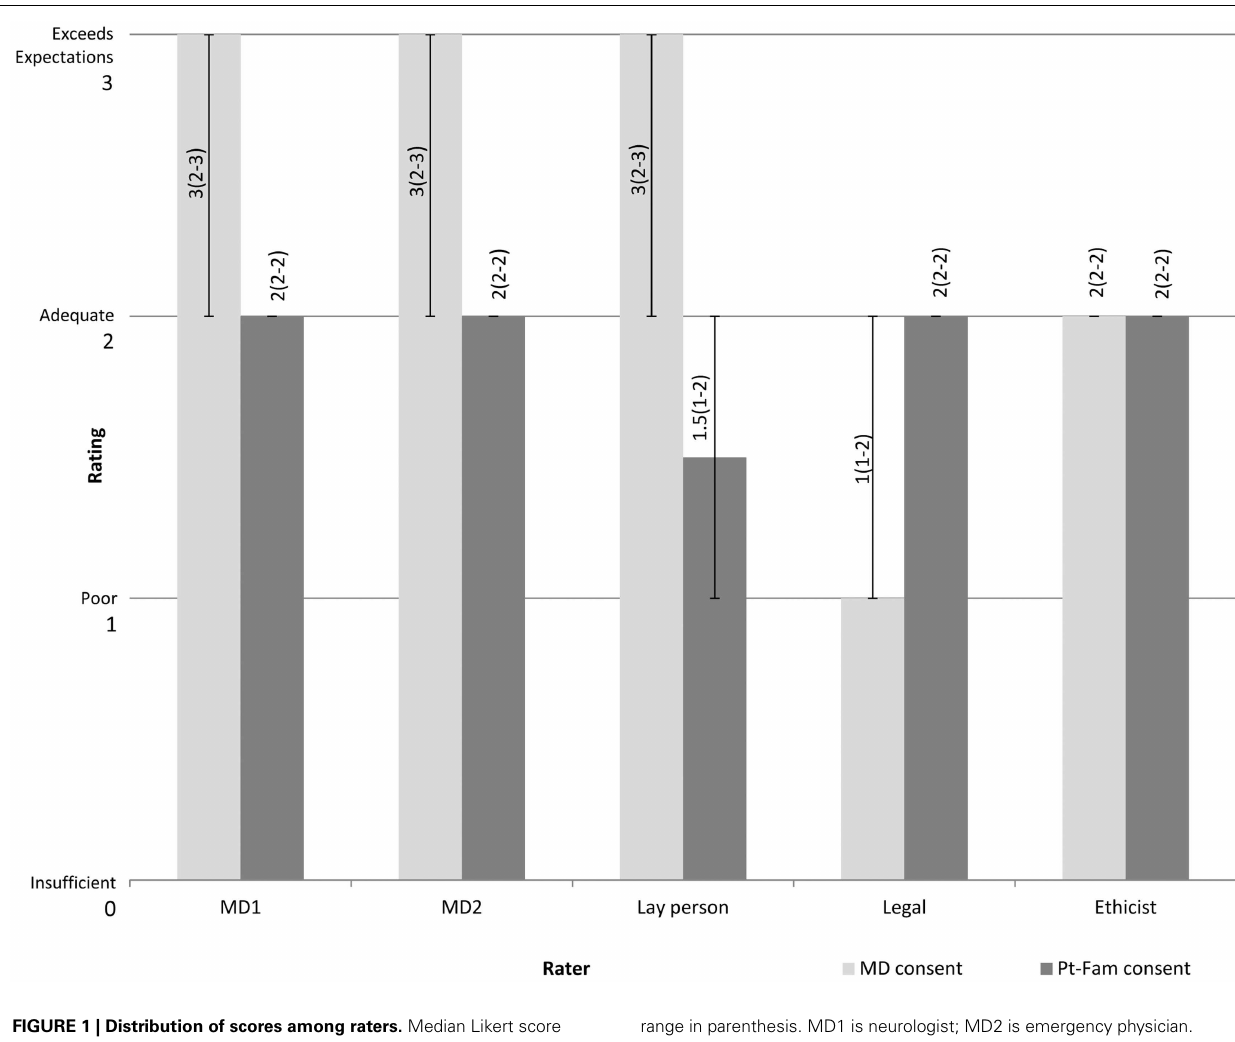
range in parenthesis. MD1 is neurologist; MD2 is emergency physician. “MD consent” refers to quality of the consent process provided by the treating physician. “Pt-Fam consent” refers to adequacy of the understanding demonstrated by the patient and/or family authorizing